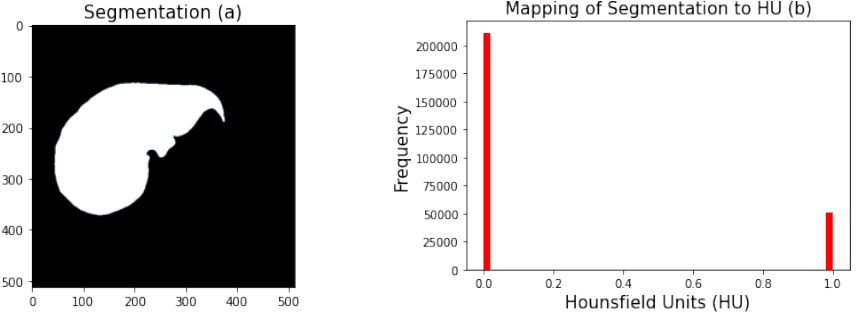
Figure 3. Binary mask plot from ‘ MASKS_DICOM ’ ( a ) and corresponding histogram of HU values ( b ).